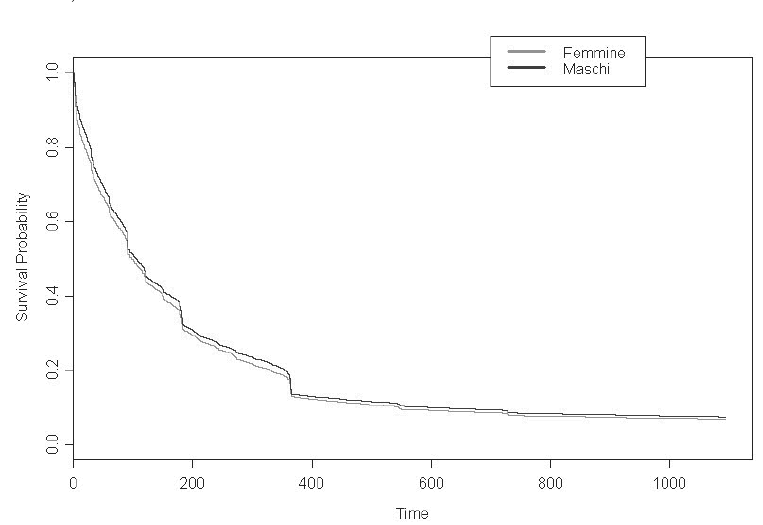
Figure 3 – Survival curves for job placements on temporary contracts, according to gender (2004- 2006) [Femmine = femals, Maschi = males].